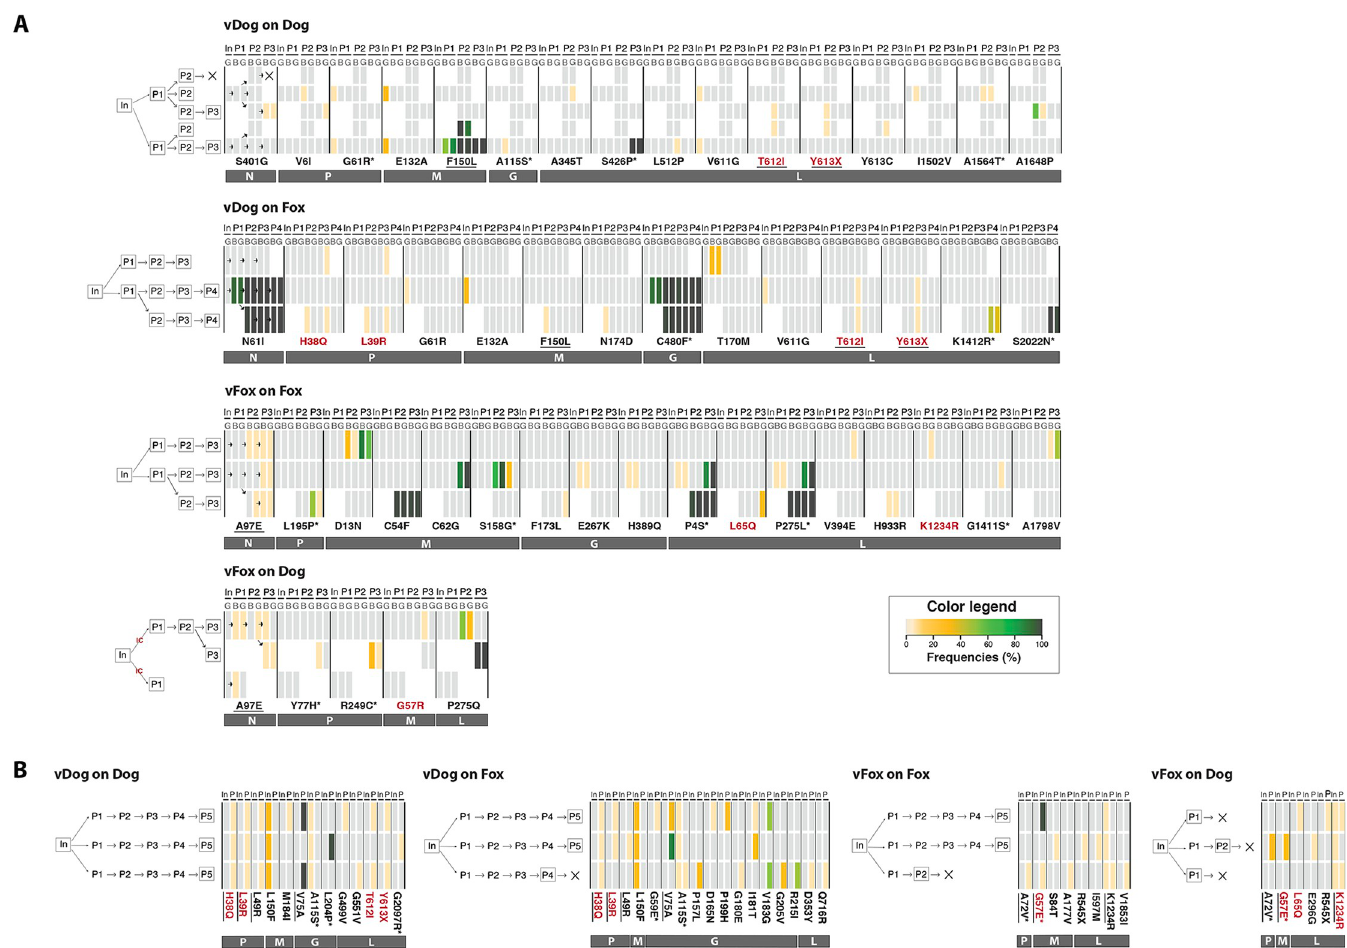
Fig 3. Heatmap of non-synonymous mutations during experimental passage. Nucleotide sites for which variability is detected above a frequency of 2% of the total viral population are shown: (A) in vivo and (B) in vitro experiments. The frequency of non-synonymous mutations in each passage (P1 to P3) is color coded (see legend). A schematic representation of experiment design is showed on the left part of each heatmap, for details see Fig 1. Mutations highlighted in red are those found both during in vivo and in vitro experiments. Mutations underlined are those observed both during intra- and inter-host passages, excluding those already observed in the inoculum . Mutations associated with an asterisk are those that have also been observed in in natura RABV strains [7]. In , Inoculum ; P, Passage; G, Salivary Gland; B,